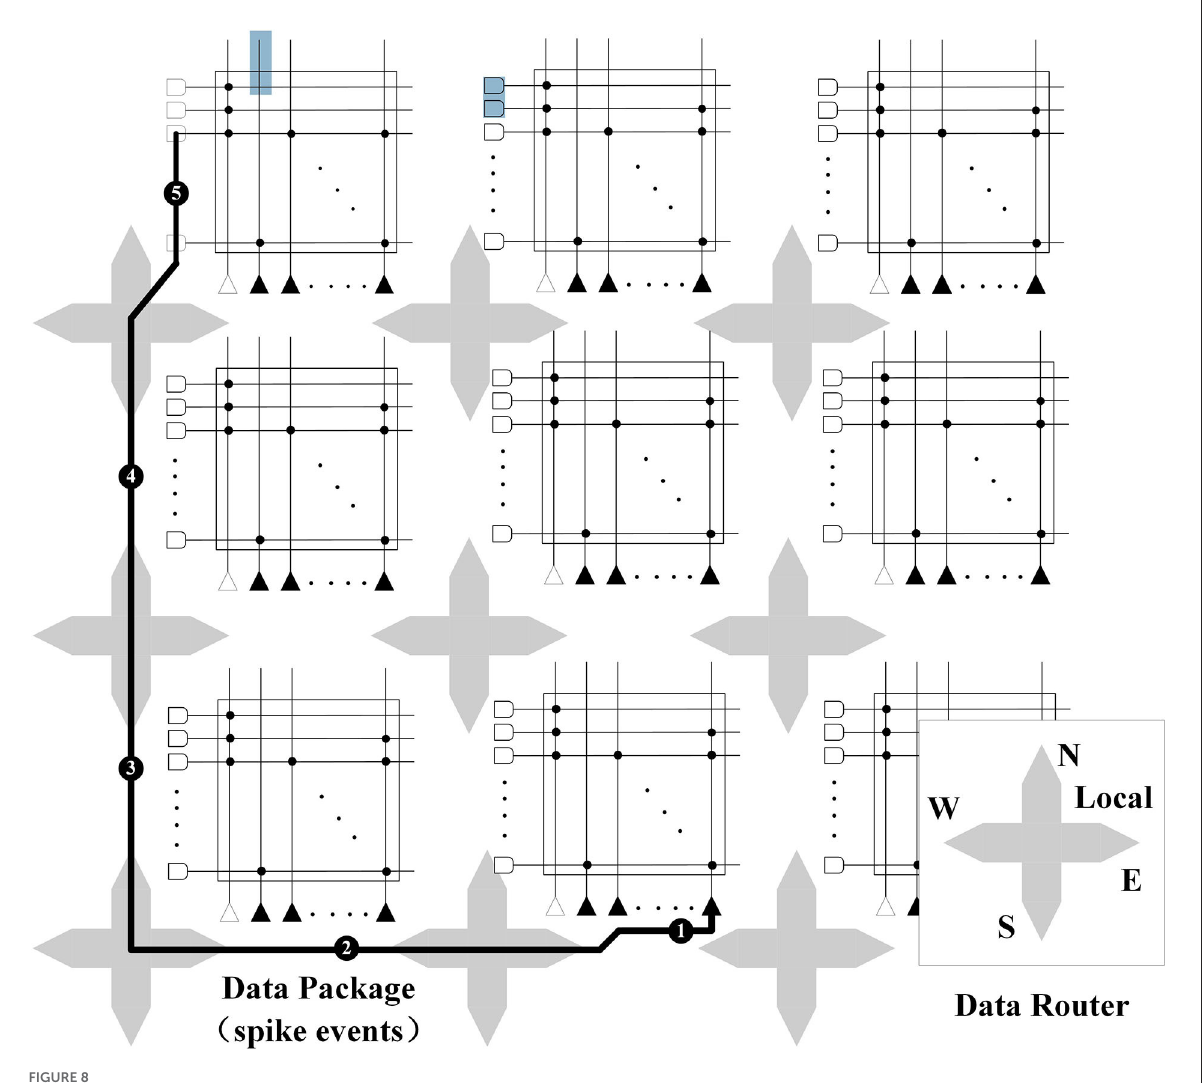
FIGURE8 The propagation of router data between core